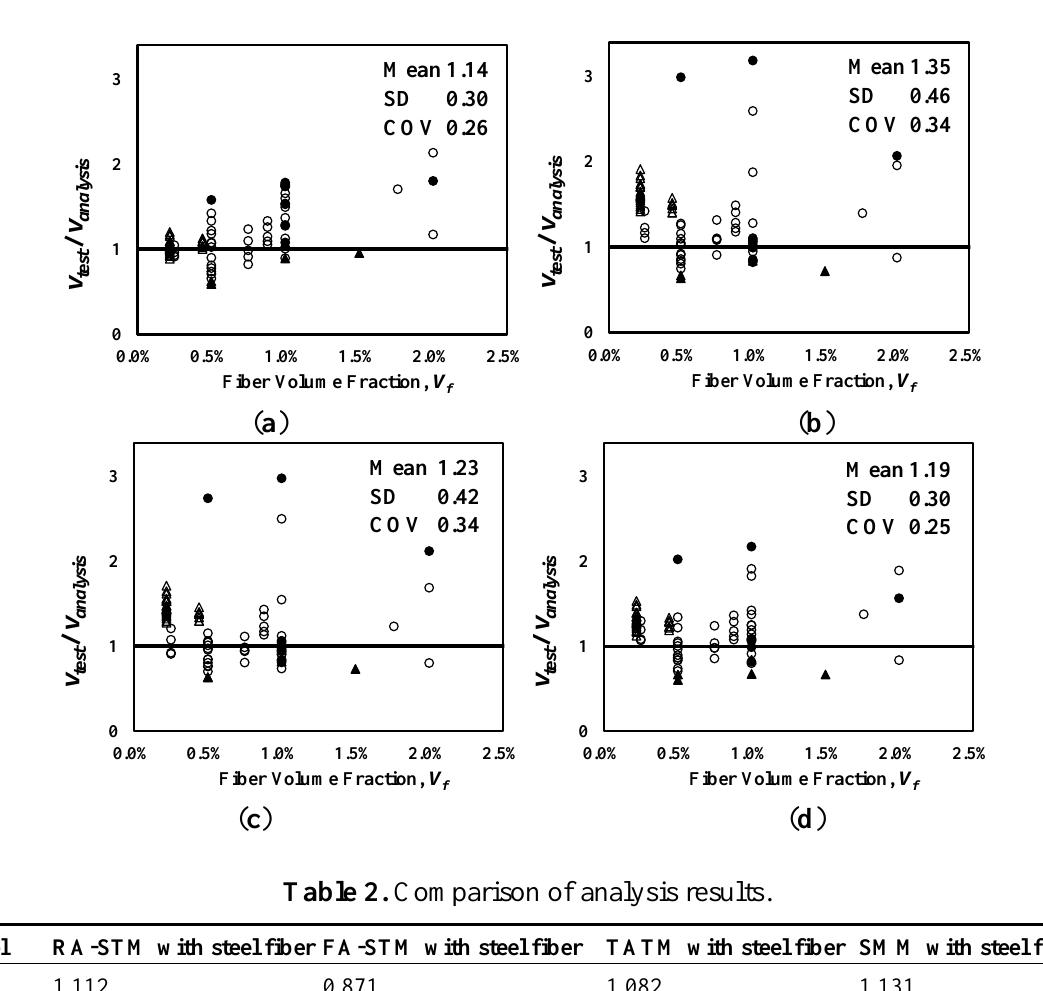
Figure 4. Comparison of analysis results. ( a ) Sharma [9]; ( b ) Narayanan and Darwish [10];